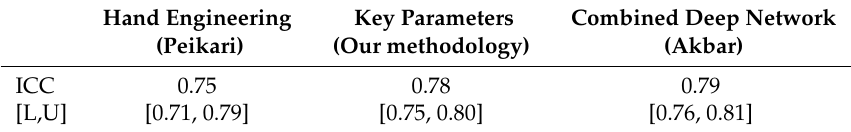
Table 2. Comparison of the Intra-class Correlation Coefficients (ICC) of the proposed methodology against a Hand Engineering Methodology (Peikari [45]) and a combined deep learning and hand engineering methodology (Akbar [20]). Lower and upper bounds are shown in square brackets. Notice the closeness of the results of the proposed methodology against the Deep Learning approach. Hand Engineering Key